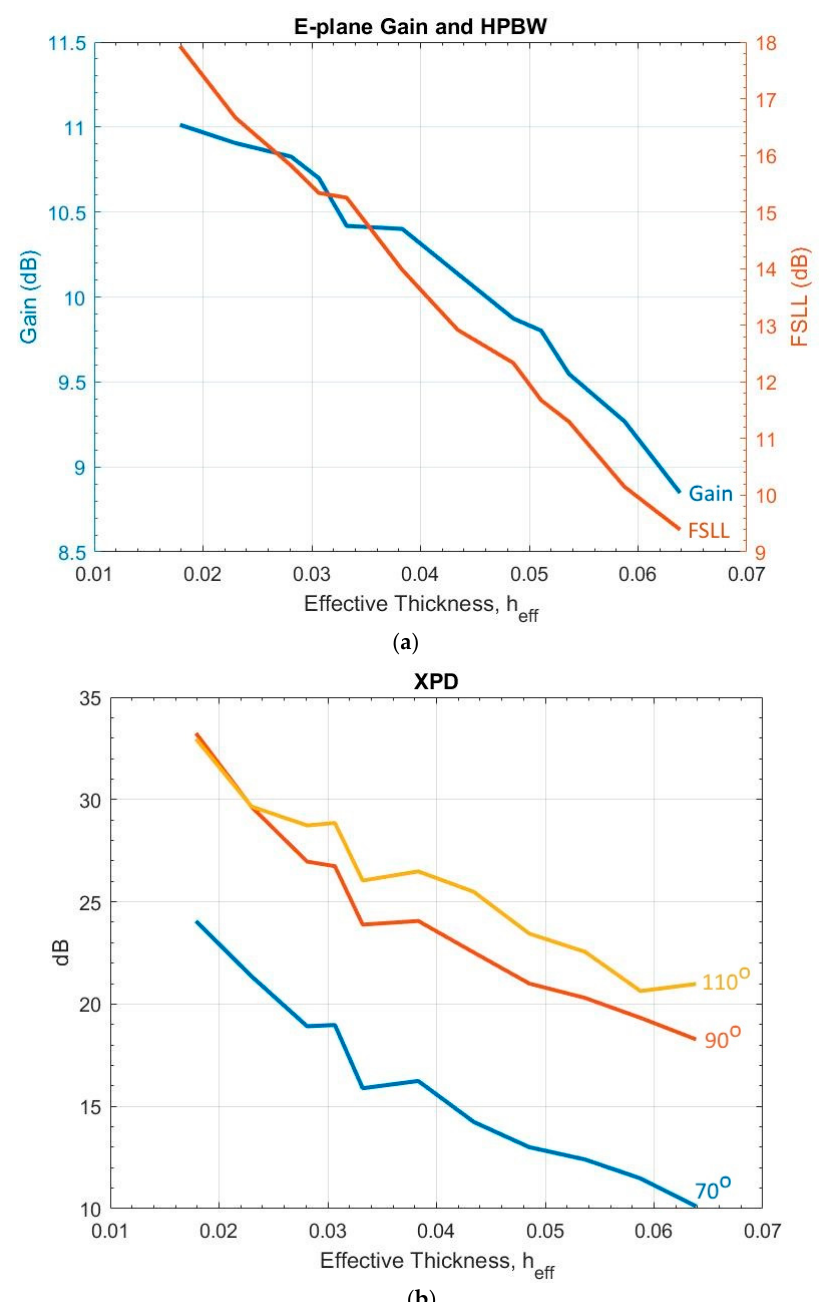
Figure 9. Variations of substrate effective thickness: ( a ) E-plane gain and HPBW; and ( b ) XPD (blue: 70°, red: 90°, yellow: 110°).